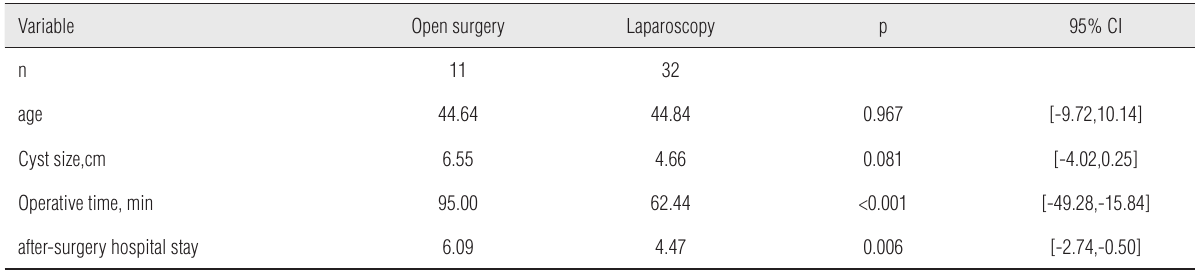
Table 2 - The demographic and clinical data of surgical intervention patients.